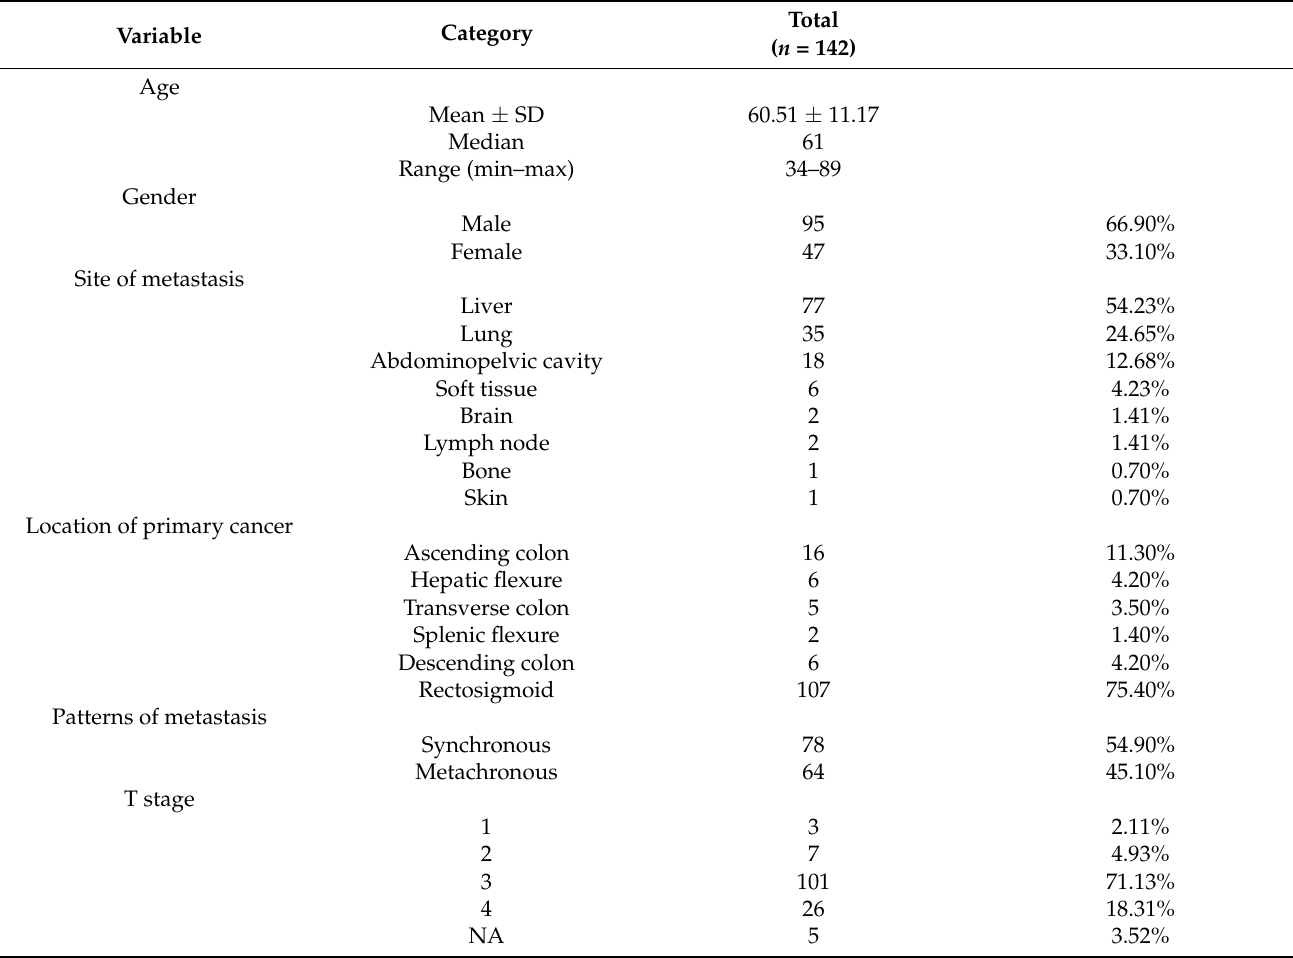
Table 1. Clinicopathologic characteristics of 142 metastatic